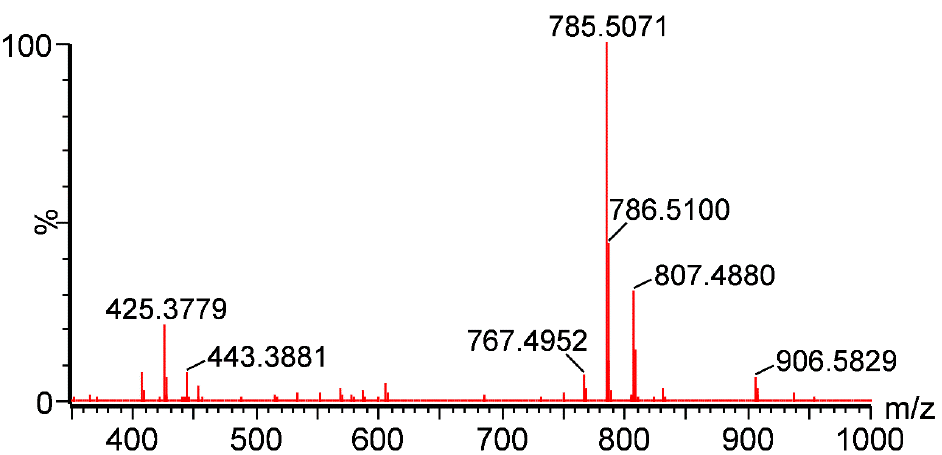
Figure 3. High-resolution quadrupole-time-of-flight electrospray-ionization mass spectrometry (HR-QTOF ESI/MS) analysis showing the product of CK. Mass analysis of product ([M + H] + m/z + 785.5060) confirmed that the product was a monogalactoside derivative of CK (C 42 H 72 O 13 , calculated molecular weight, [M + H] + m/z + 785.505).